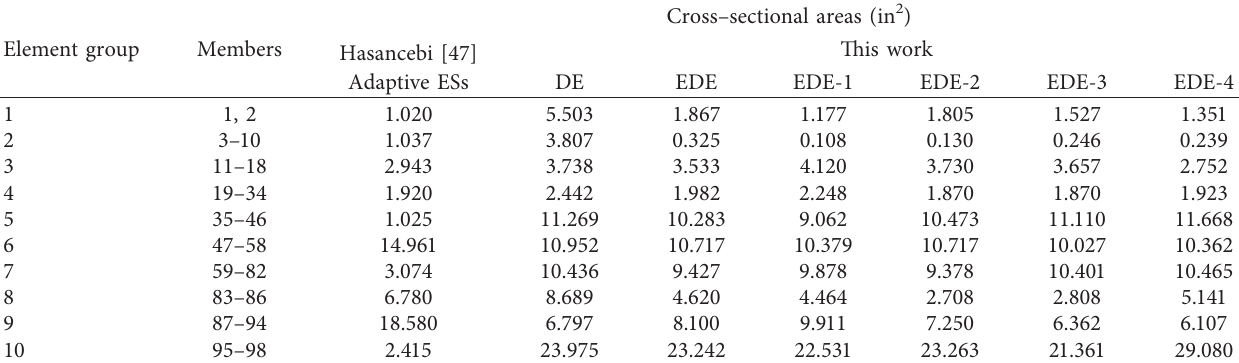
Figure 15: Element numbering and sizes of the 942-bar truss (reproduced from Hasancebi [47], under the Creative Commons Attribution License/public domain). Table 8: Performance comparison of the 942-bar